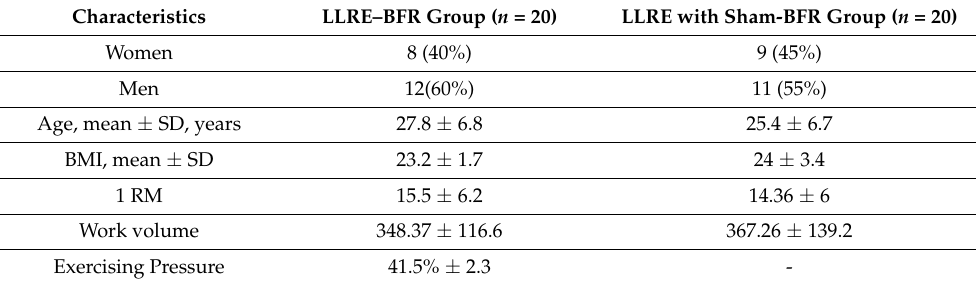
Table 1. Participants’ baseline characteristics and exercise parameters in the LLRE–BFR and the HLRE with sham-BFR group.